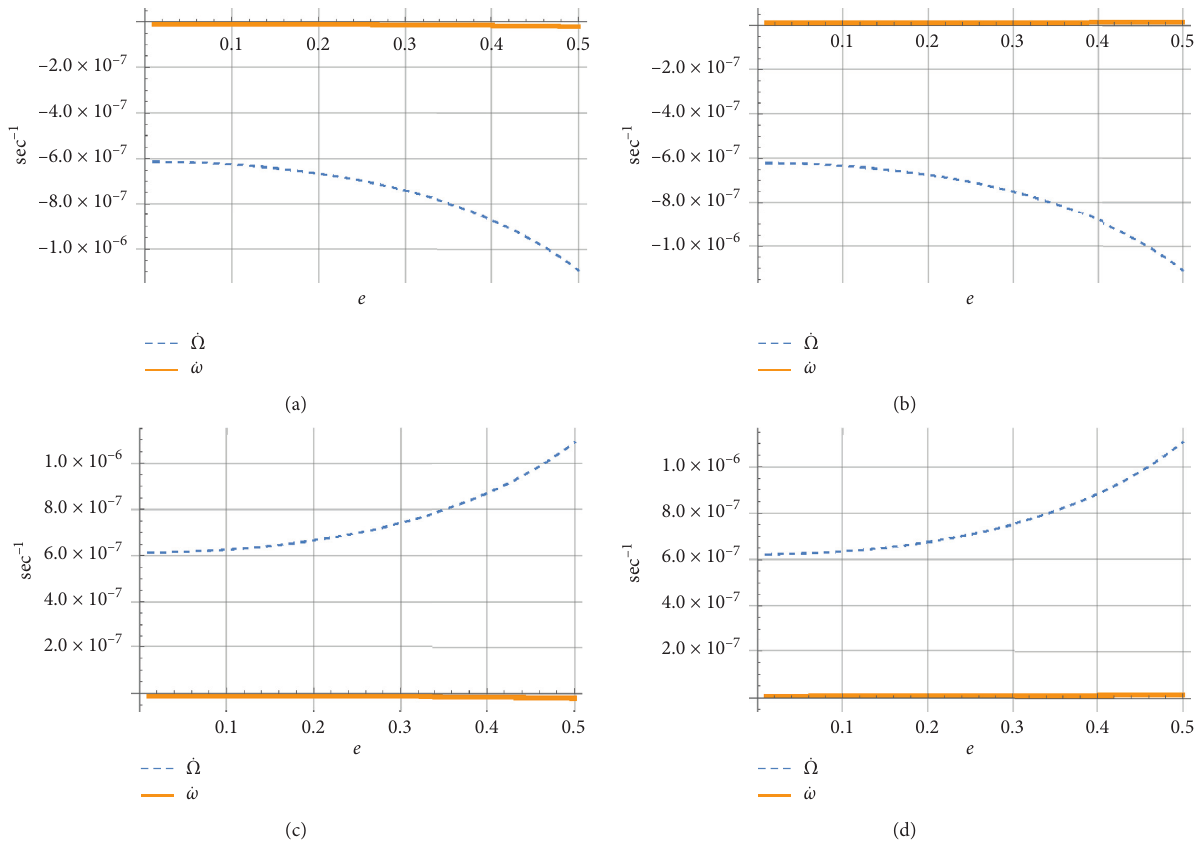
Figure 4: Curves of _ Ω and _ ω with e for the 4 cases corresponding to F ( i ) � 0.01. (a) i � 63 . 63, (b) i � − 63 . 22, (c) i � 116 . 37, and (d) i � 116 .